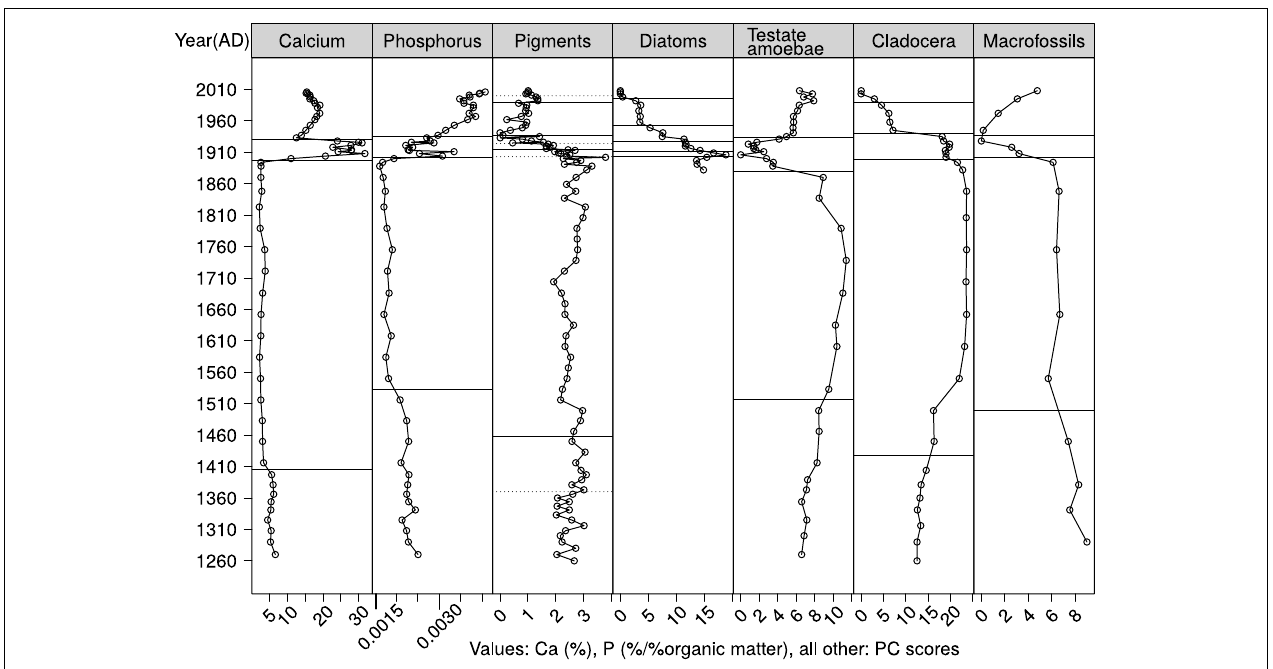
FIGURE 5 | Ca and P, and PCs of biological groups against time. Horizontal lines indicate MRT-derived splits, those dashed to aid inspection indicate least importance.